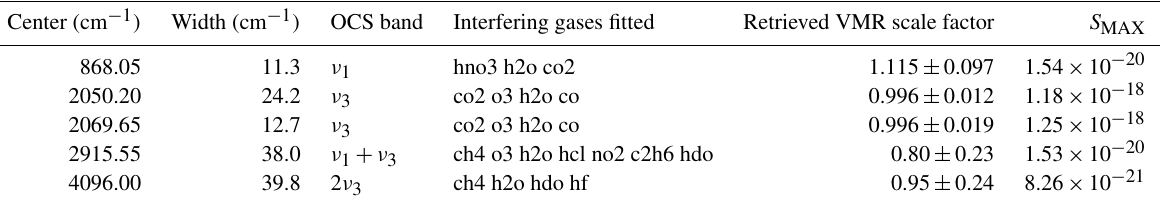
Table 2. Attributes of the five spectral windows used to fit OCS in MkIV balloon spectra. Center and Width denote the center wavenumber and width of the window. OCS band denotes the vibration–rotation state to which the OCS molecules were excited. The Retrieved VMR scale factor shows how the average OCS amounts retrieved from a particular window compare with the mean of all windows. S MAX is the maximum line intensity in units of cm − 1 (molec.cm − 2 ) − 1 . The windows centered at 2050 and 2070cm − 1 cover the P - and R -branches